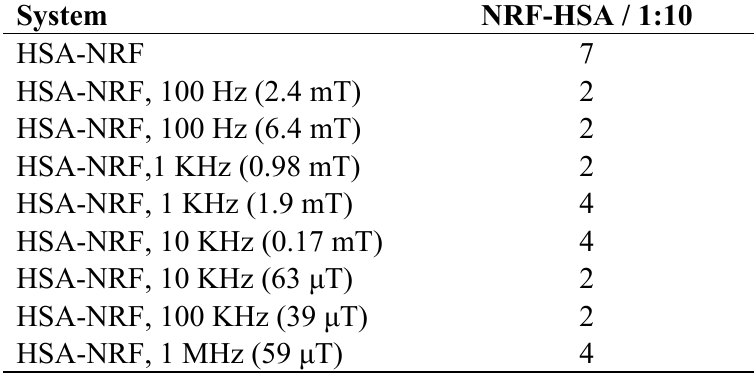
Table 3. The REES values of HSA-NRF in the absence and presence of different